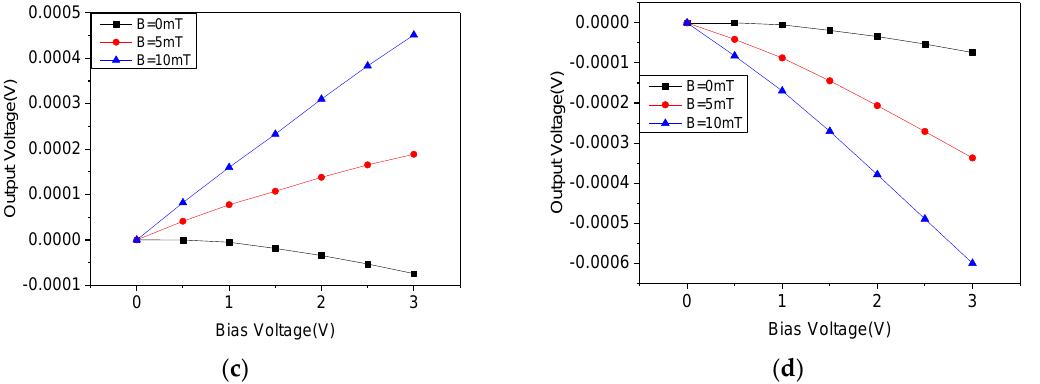
Figure 11. The output voltages between the Hall electrodes of the orthogonal coupled structure. ( a ) Phase 0; ( b ) Phase 90; ( c ) Phase 180; ( d ) Phase 270.